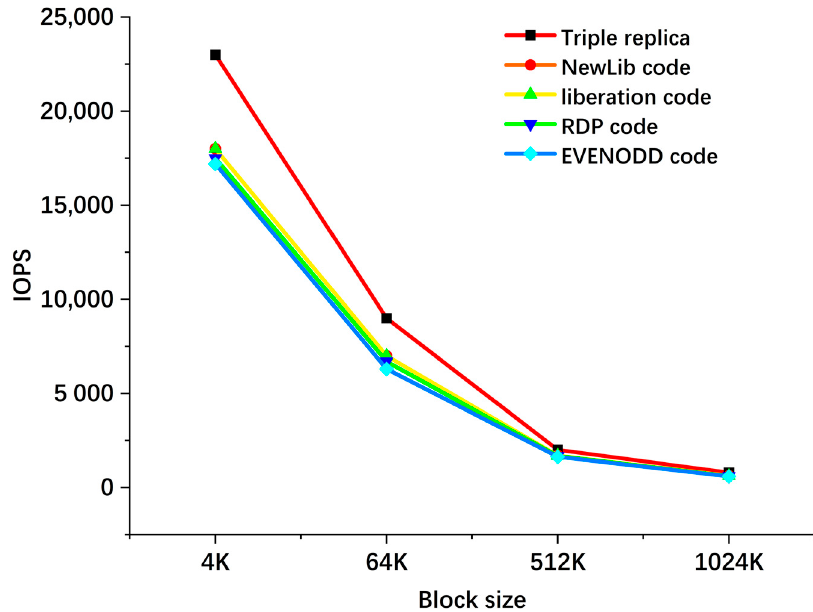
Figure 11. The IOPS in the random reading.